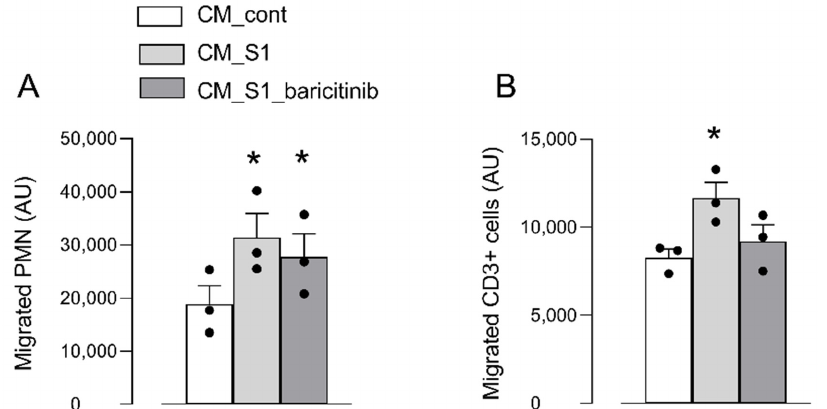
Figure 3. Human polymorphonucleates (PMN, Panel ( A )) and T lymphocytes (CD3+ cells, Panel ( B )) were isolated and allowed to migrate through confluent HUVECs grown on transwell inserts towards CM_cont, CM_S1 or CM_S1_baricitinb. After 4 h (PMN) or 24 h (CD3+ cells), the amount of transmigrated cells in the lower compartment was determined as described in Materials and Methods. Bars are the mean ± SEM of three independent determinations (single dots). * p < 0.05 with one-way ANOVA.